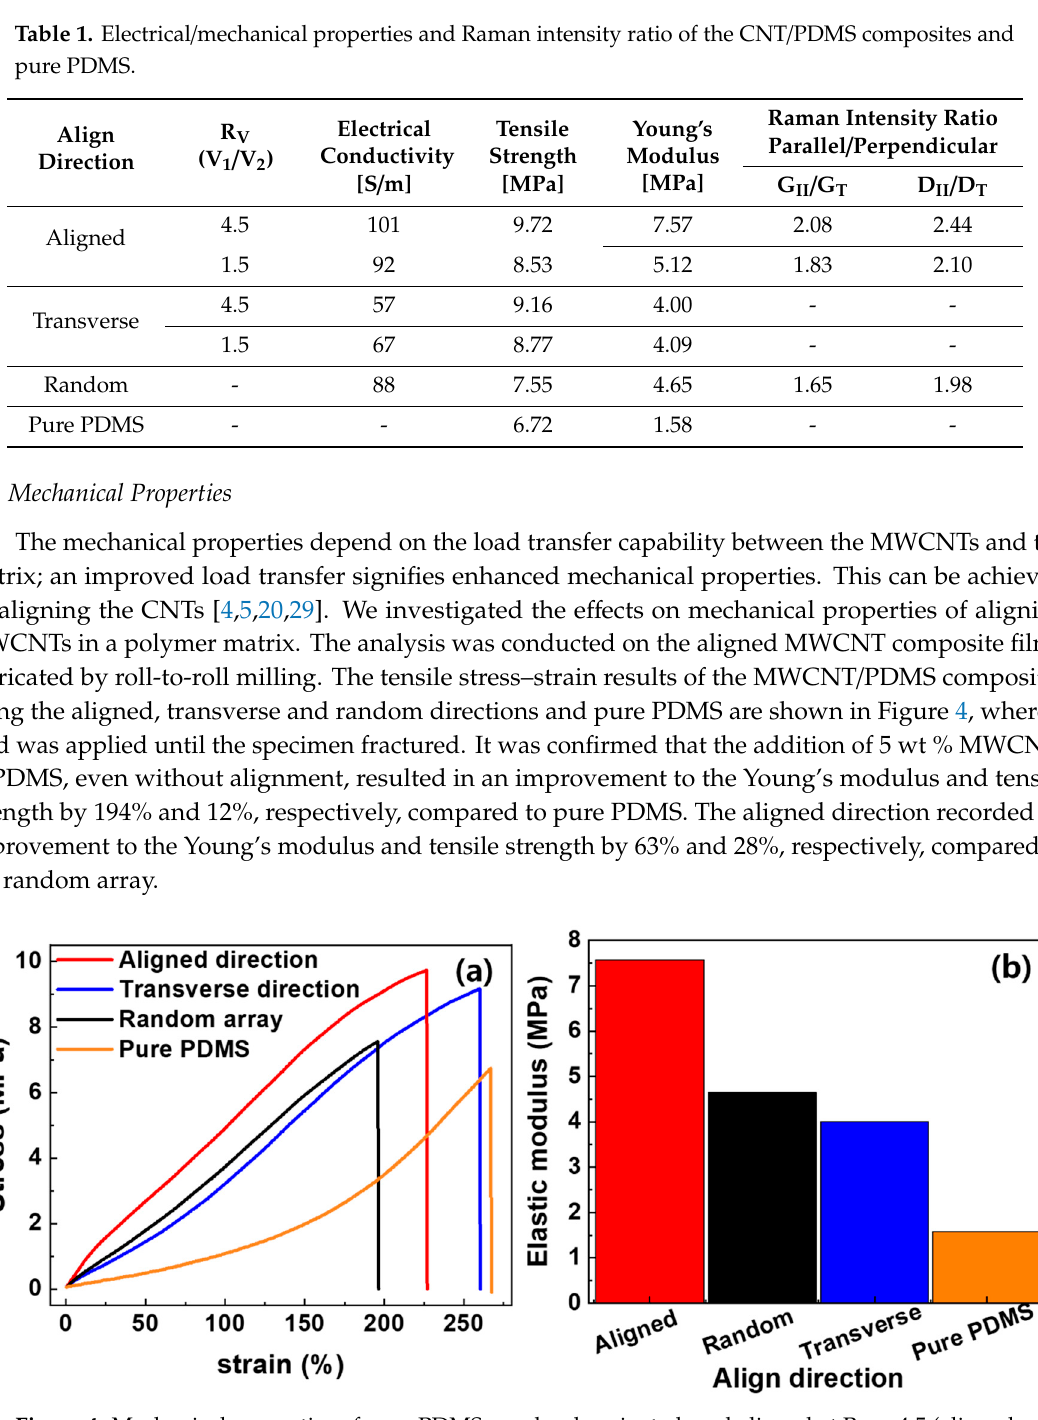
Figure 4. Mechanical properties of pure PDMS, randomly oriented, and aligned at R V = 4.5 (aligned and transverse direction) MWCNT / PDMS composites; ( a ) stress–strain curve and ( b ) elastic modulus .